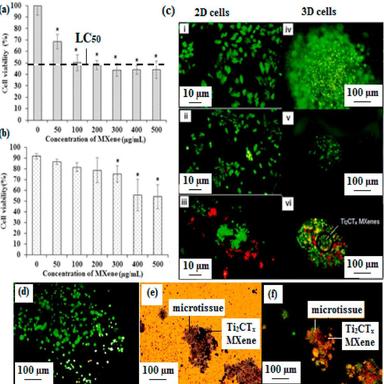
The results of cytotoxicity studies: cells viability after 24 h treatment with different concentrations of the Ti2CTx MXenes (50–500 μg/mL) on HeLa cells, measured using (a) MTT assay and (b) Muse ® Cell flow cell cytometer. The results presented are the mean of three independent experiments and the error bars shown represents the standard deviation with n = 3.It is also \p < 0.05 indicates significant to control, using Student independent t-test. (c) Live and dead cell staining images of 2D HeLa cells afte